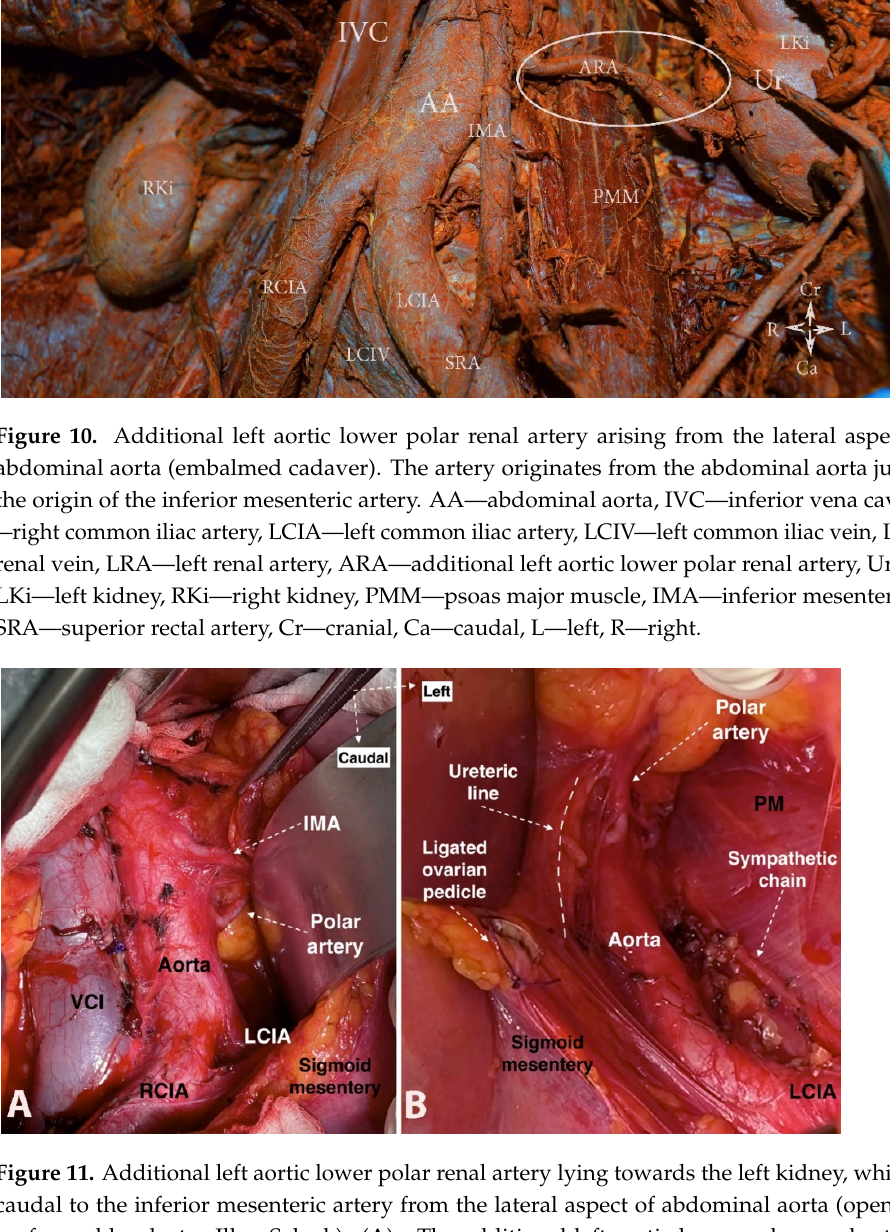
Figure 11. Additional left aortic lower polar renal artery lying towards the left kidney, which aris- es caudal to the inferior mesenteric artery from the lateral aspect of abdominal aorta (open surgery performed by doctor Ilker Selcuk). ( A )—The additional left aortic lower polar renal artery after lateralization of the sigmoid mesentery. ( B )—The additional left aortic lower polar renal artery af- ter medial mobilization of the sigmoid